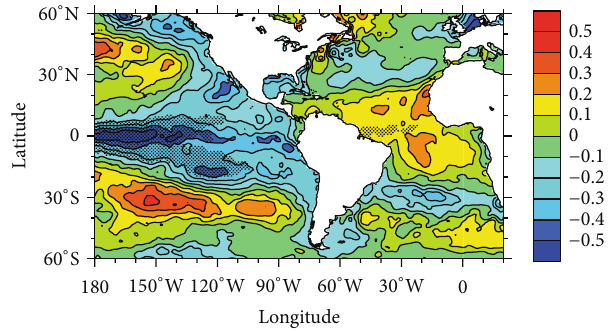
Figure 19: Annual mean sea surface temperature (K) anomaly for HCSA poleward expansion cases in the period 1996–2011 based on the HADISST dataset. Contour intervals are 0.1 K with stippling indicating regions statistically significant above the 95% confidence level as determined by two-tailed Student’s 𝑡